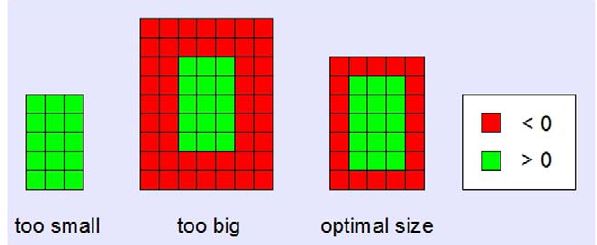
Figure 9. Voxelized representation of collagen fibers. The figure shows three adjacent original confocal images (left) and the corre- sponding reconstruction result (right). The broadened fiber is reduced to a wiggly, continuous line with a ‘diameter’ of one voxel.